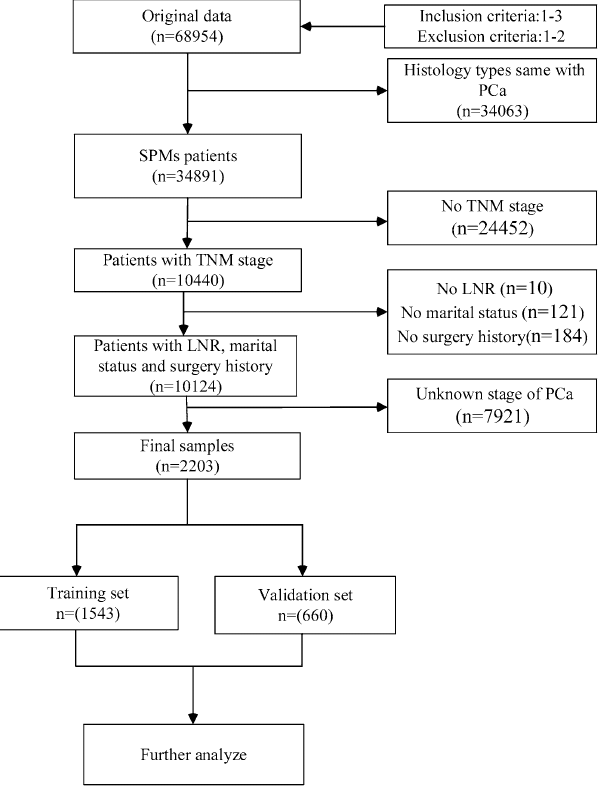
Figure 1. Study flowchart showing the process of constructing nomogram to predict the overall survival (OS) of second primary malignancies (SPMs) after prostate cancer